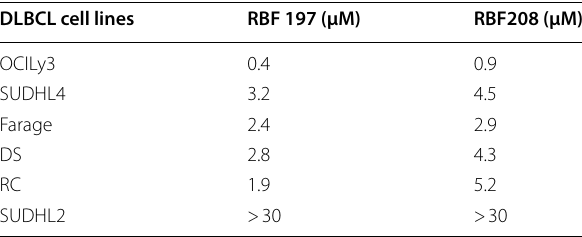
Table 2 IC values of RBF197 and RBF208 in a panel of six 50 DLBCL cell lines using WST-1 assay DLBCL cell